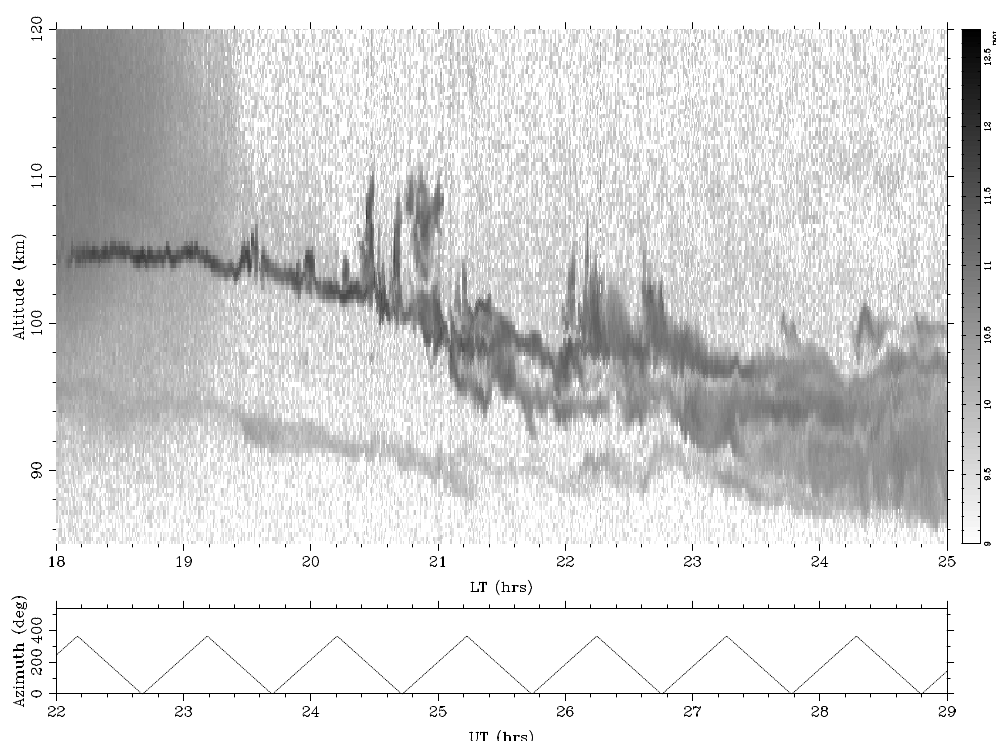
Fig. 5. Electron densities measured with the Arecibo Gregorian